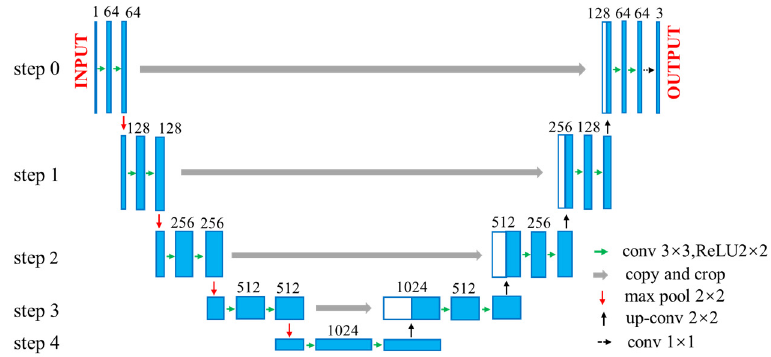
Figure 2. U-Net architecture.